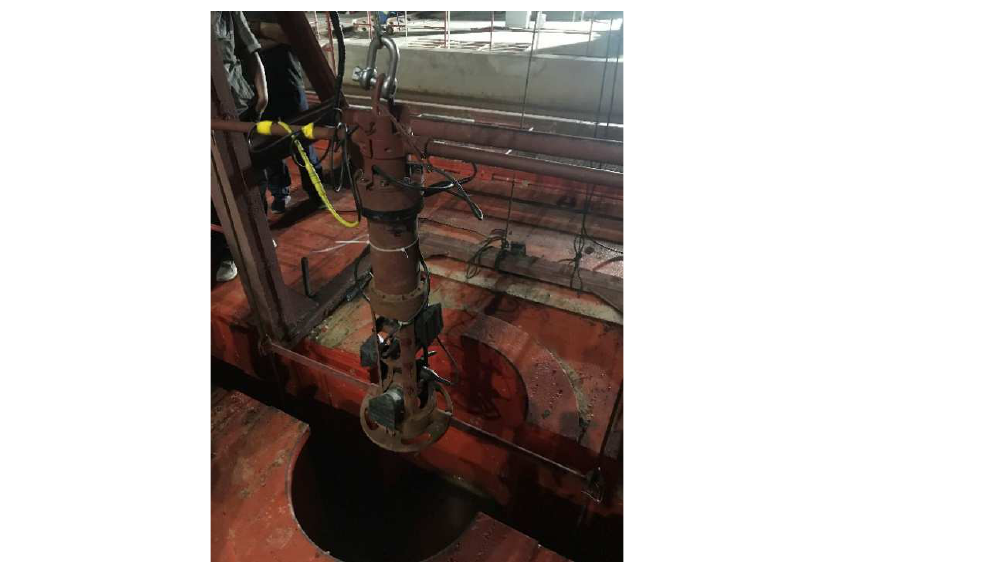
Figure 1. ULISSD used to log the central-air-return shaft.